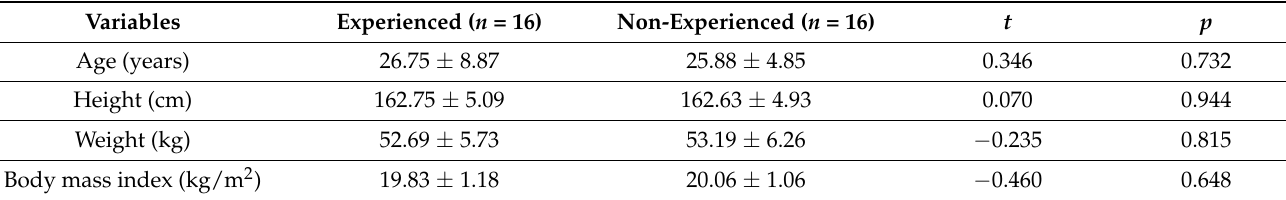
Table 1. General characteristics of